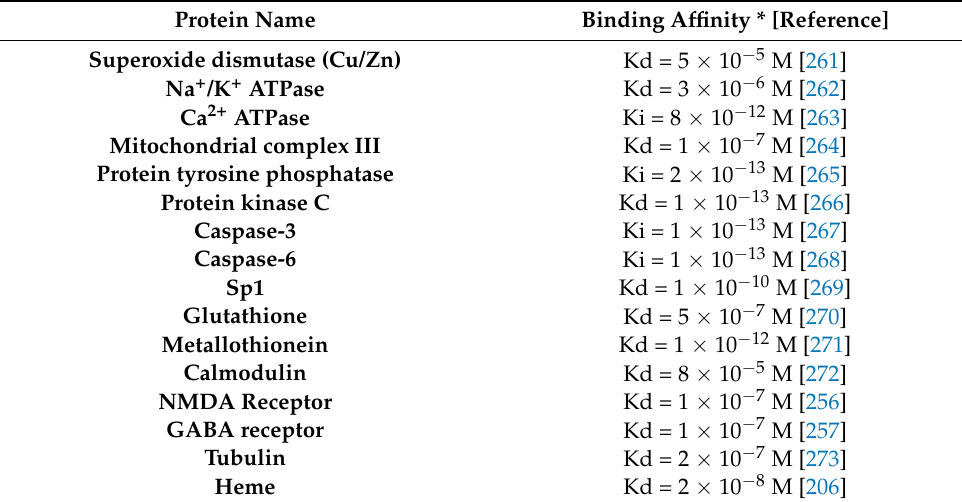
Table 1. Tabulated list of selected proteins and enzymes with known binding affinity and inhibitory constant for